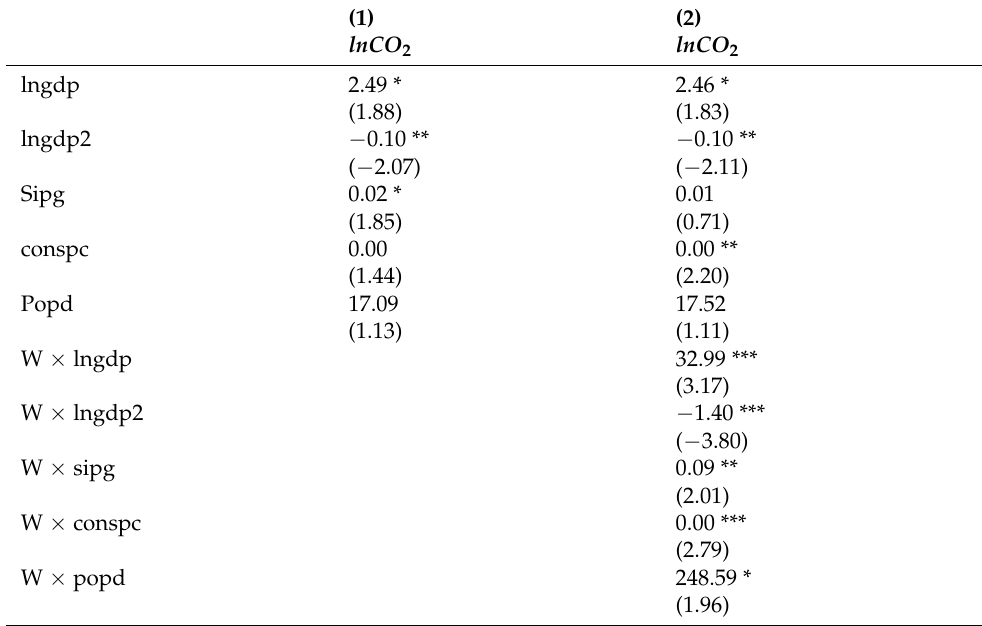
Table 3. Spatial model estimation